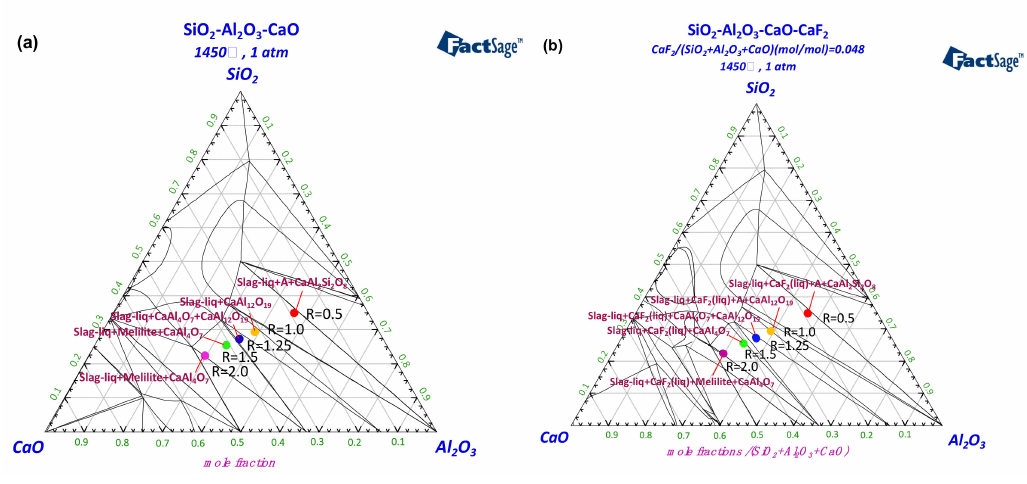
Figure 5. Thermodynamic phase diagrams of the ( a ) CaO–SiO 2 –Al 2 O 3 system and ( b ) CaO–SiO 2 –Al 2 O 3 –CaF 2